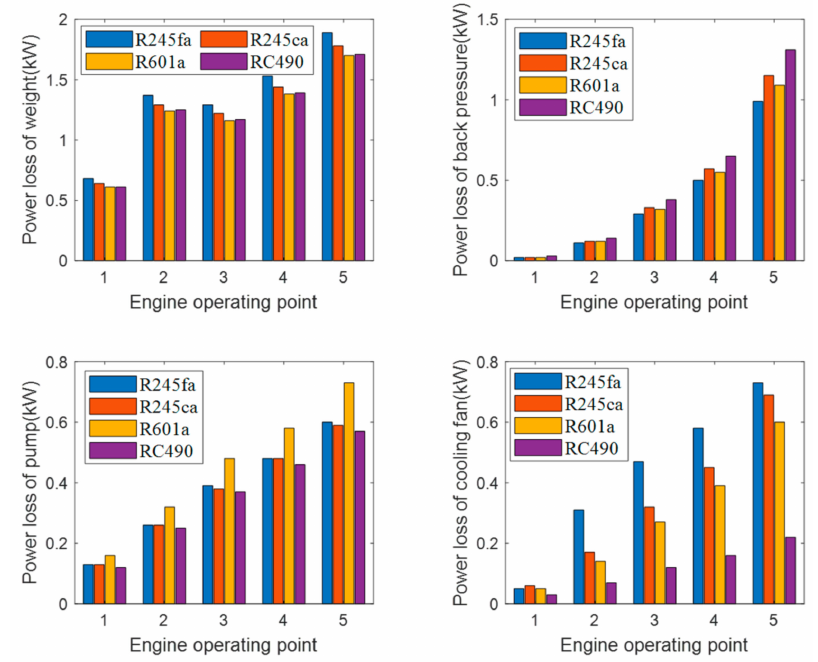
Figure 5. The power losses for ORC using different working